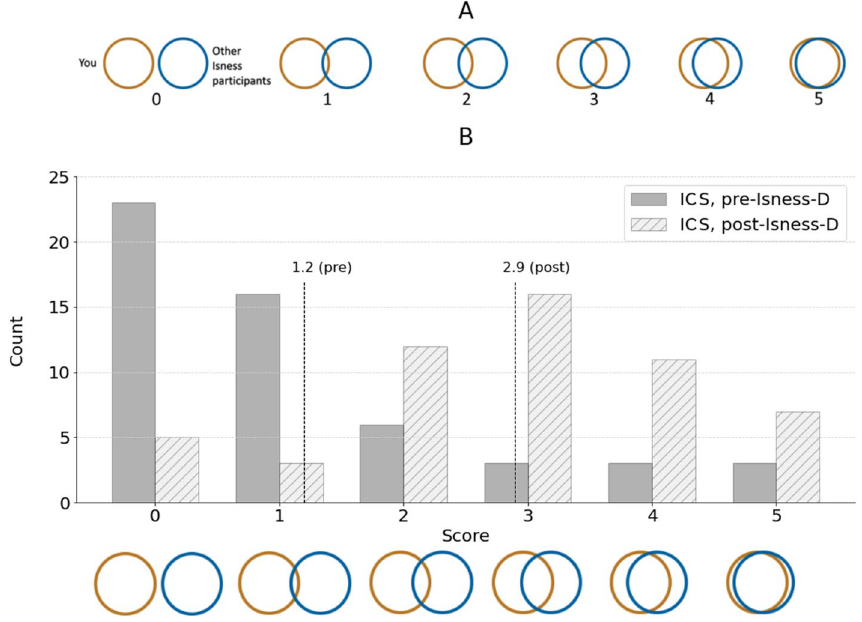
Figure 5. Panel ( A ) shows the ICS scale shown to participants in the pre-Isness-D and post-Isness-D questionnaire. Each picture has been labelled numerically from 0 to 5 for analysis, however, the pictures in the questionnaires were labelled alphabetically from (a) to (f). Panel ( B ) gives histograms of the ICS scores for all participants before and after Isness-D, with dashed lines indicating the respective